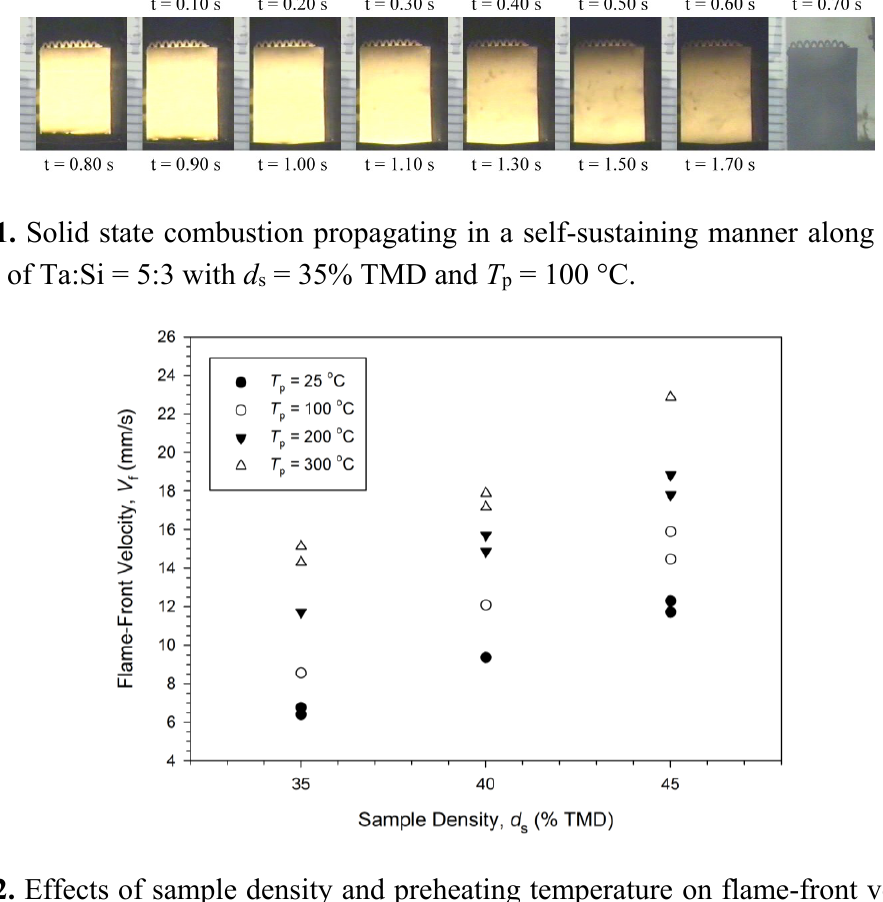
Figure 2. Effects of sample density and preheating temperature on flame-front velocity of elemental powder compacts of Ta:Si =